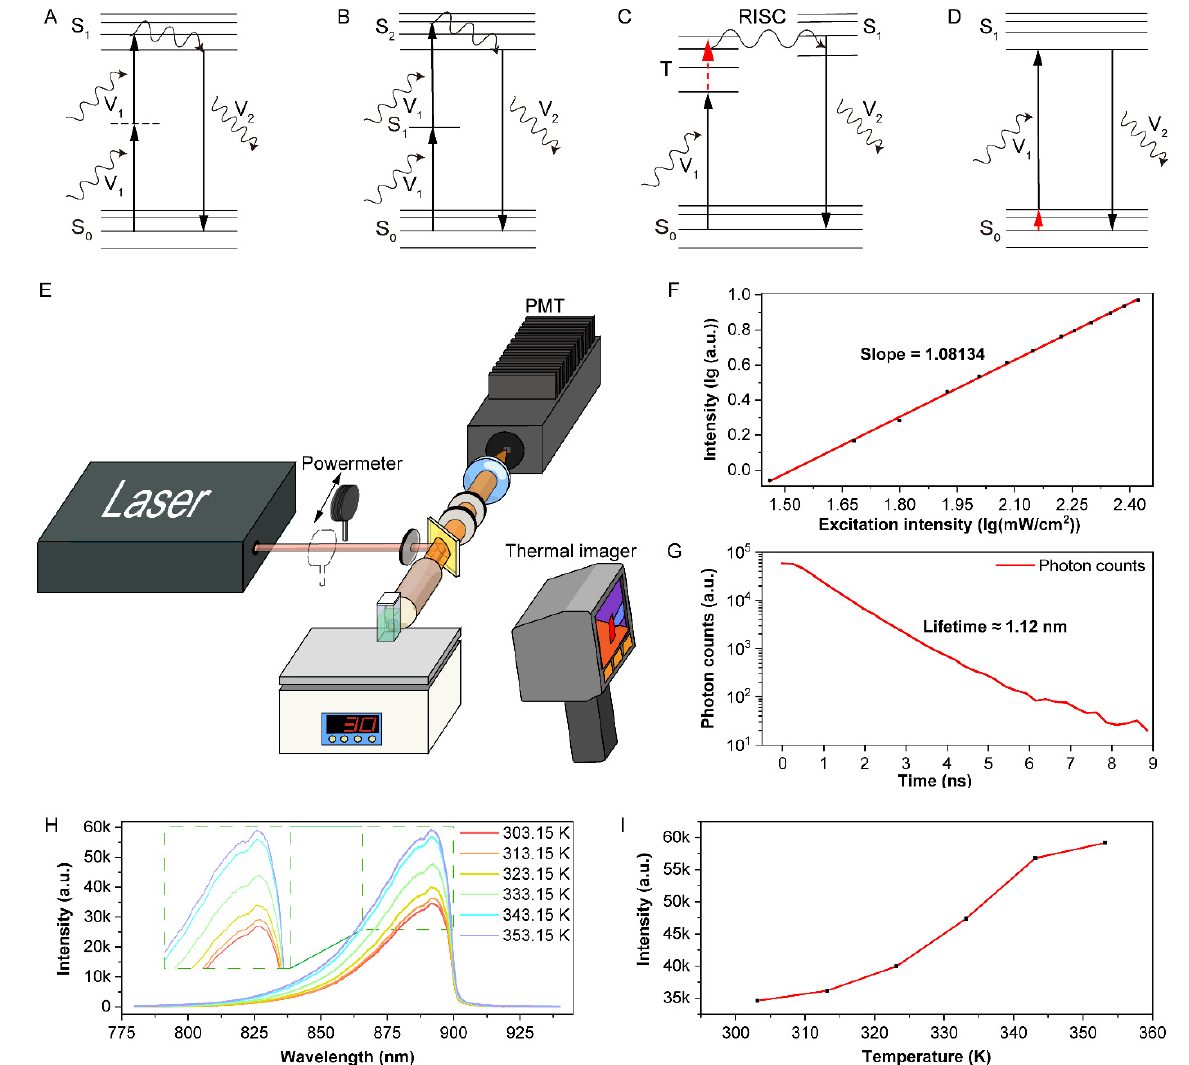
Figure 2. Mechanism of anti-Stokes fluorescence in BPN-BBTD dots. ( A–D ) Schematic illustrations of typical anti-Stokes fluorescence processes. ( A ) Two-photon absorption process. ( B ) Upconversion process based on multi-step absorption through intermediate energy levels. ( C ) Thermally activated delayed fluorescence process. ( D ) HBA process. ( E ) Optical setup for the power dependence measurement at various temperatures. ( F ) The logarithmic plot of anti-Stokes fluorescence intensity versus excitation light power (980 nm continuous-wave laser). The black squares and the solid line show the raw data and the fitted curve, respectively, showing a linear dependence of slope 1.08134. ( G ) The photon counts were plotted as a function of time under the 980 nm fs excitation, the lifetime of anti-Stokes fluorescence was about 1.12 ns. ( H ) anti-Stokes fluorescence spectra of BPN-BBTD dots in an aqueous dispersion at different temperatures. ( I ) The variation of anti-Stokes fluorescence peak intensity at different temperatures under a 980 nm excitation.